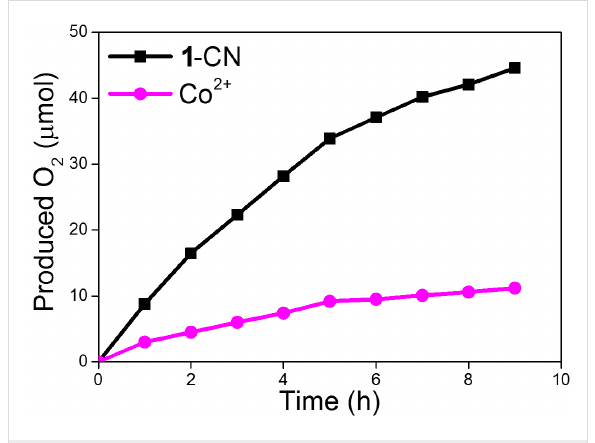
Figure 6: Long-time course of water oxidation for 1 -CN and Co 2+ under UV–vis light irradiation ( λ >300